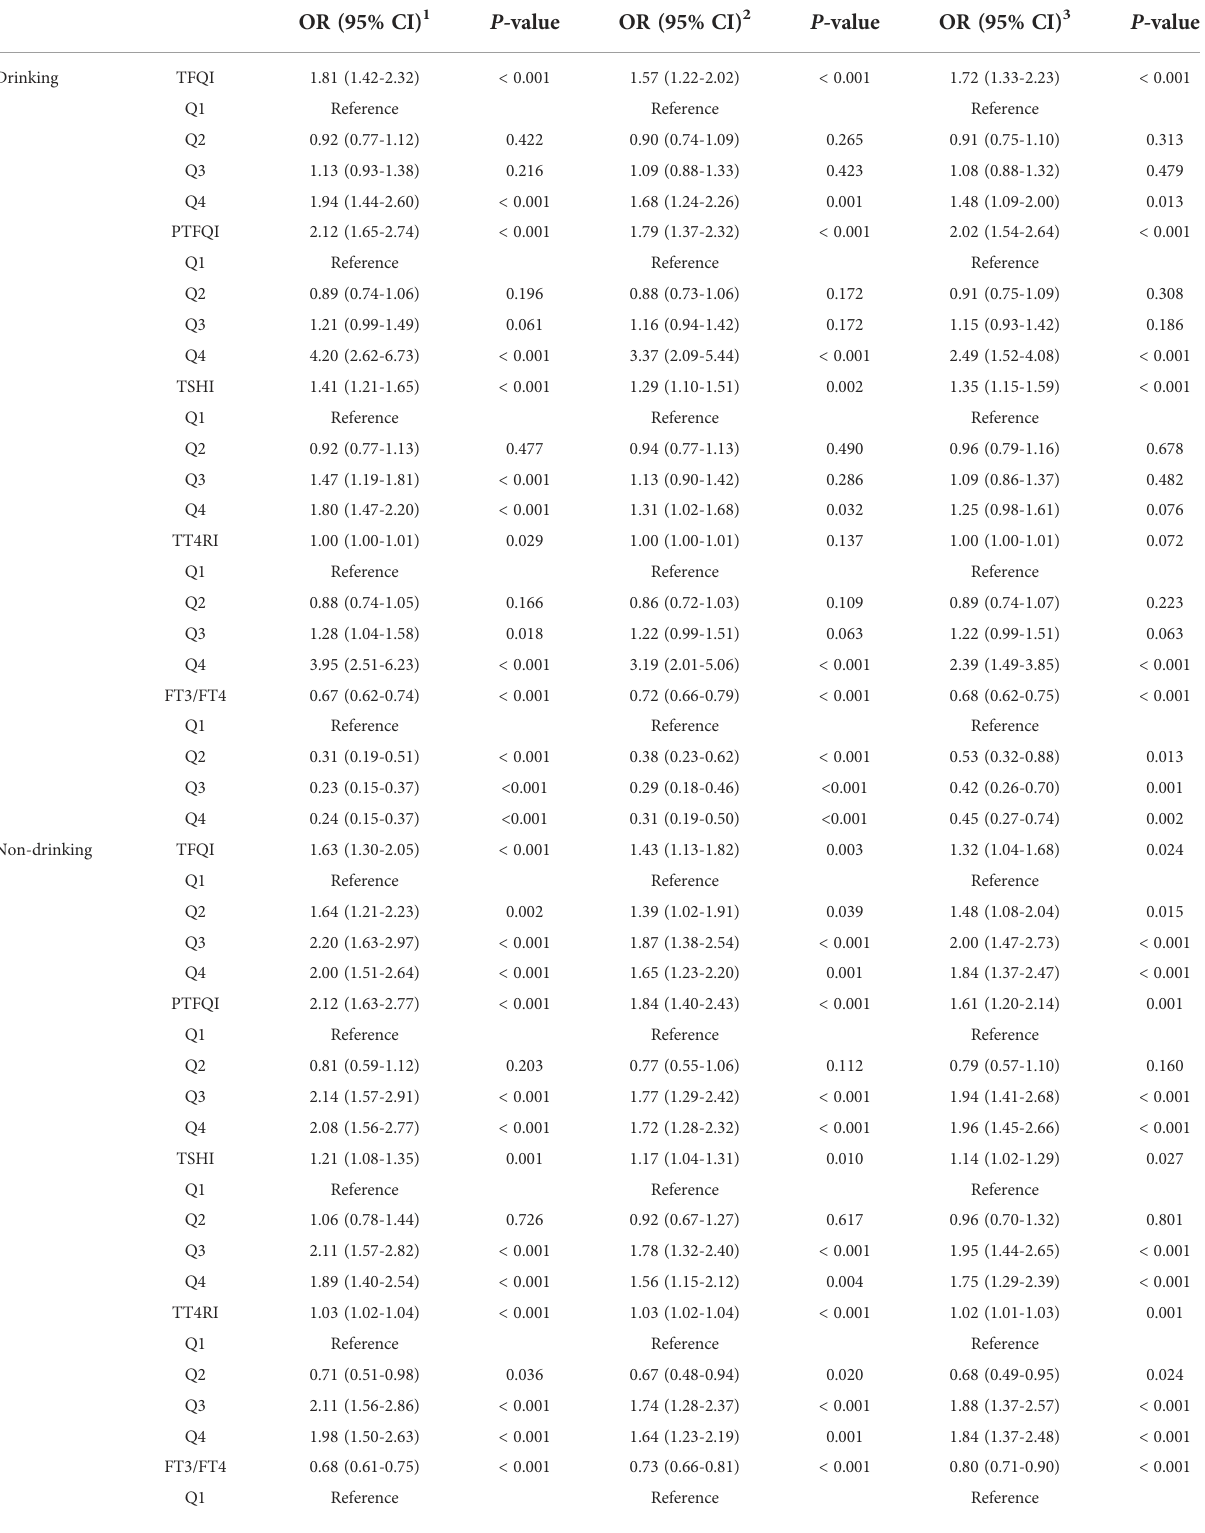
TABLE 6 Association between thyroid hormone sensitivity and carotid plaque according to drinking. Group